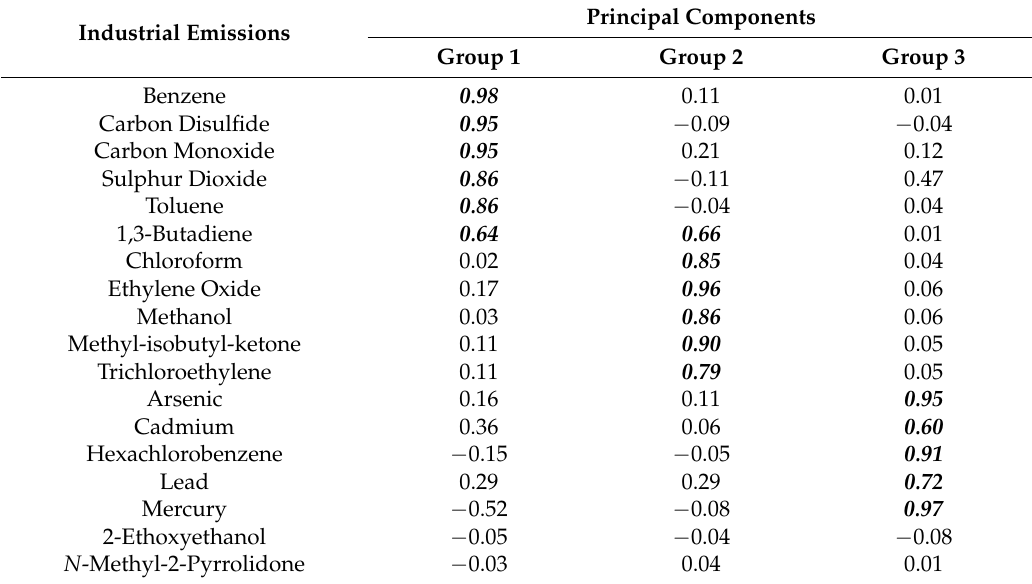
Table 1. Principal Component Analysis matrix of the 18 industrial emissions included in the study. Principal Components Industrial Emissions Group 1 Group 2 Benzene Carbon